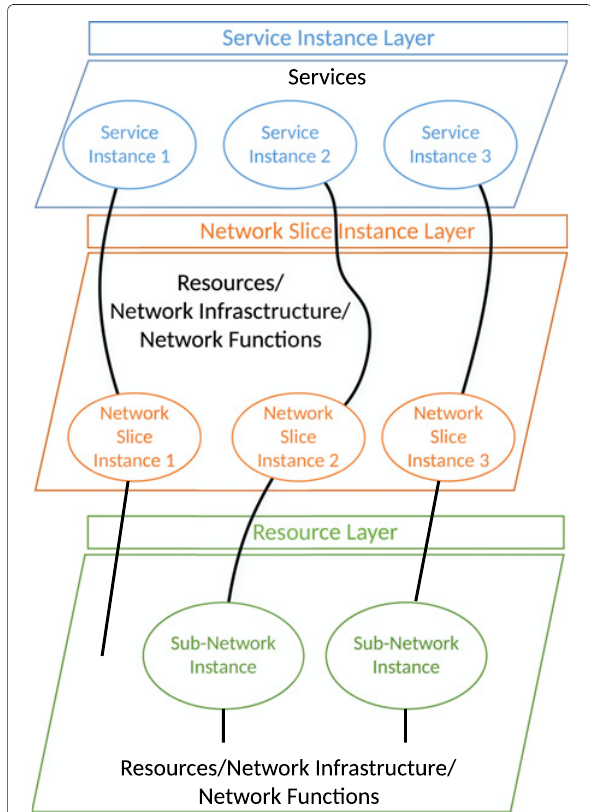
Fig. 1 Network slicing layers, based on [30]